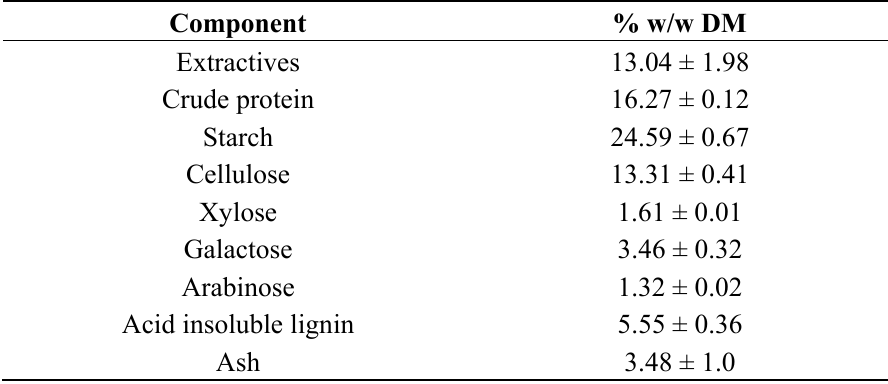
Table 2. Composition of L.